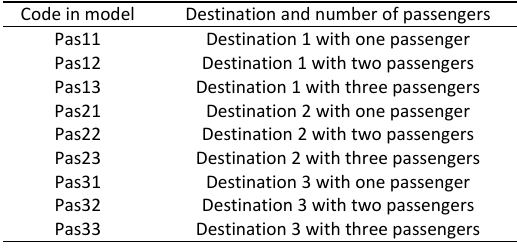
Table 1.Coding method for 9 option Table 1. Coding method for 9